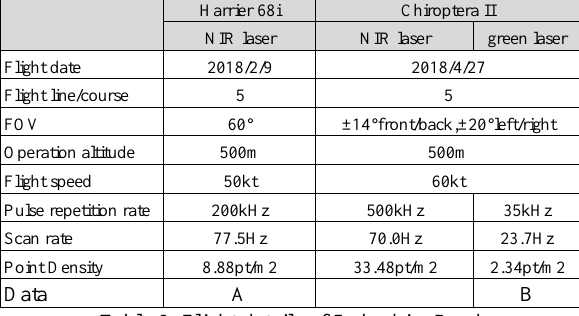
Table 3. Flight details of Inokashira Pond